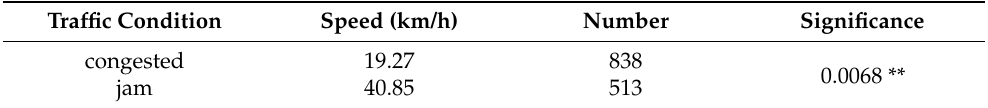
Table 3. Results of traffic flow clustering based on speed.